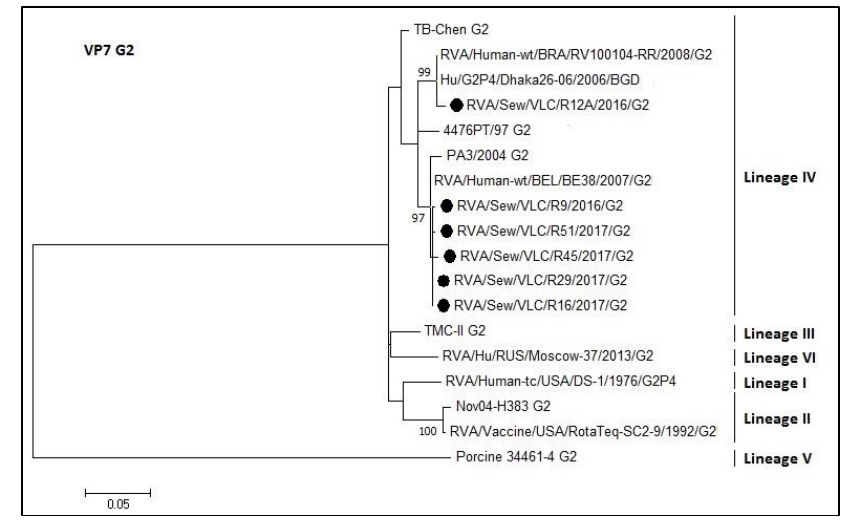
Figure 5. Molecular phylogenetic analysis of G1 rotavirus (VP7 gene). The evolutionary history was inferred by using the Maximum Likelihood method based on the Tamura 3-parameter model [43] with a bootstrap of 1000 replicates. The tree is drawn to scale, the branch lengths measure the number of substitutions per site. The analysis included 16 nucleotide sequences. There were 416 positions in the final dataset including nucleotides from 358 to 774.